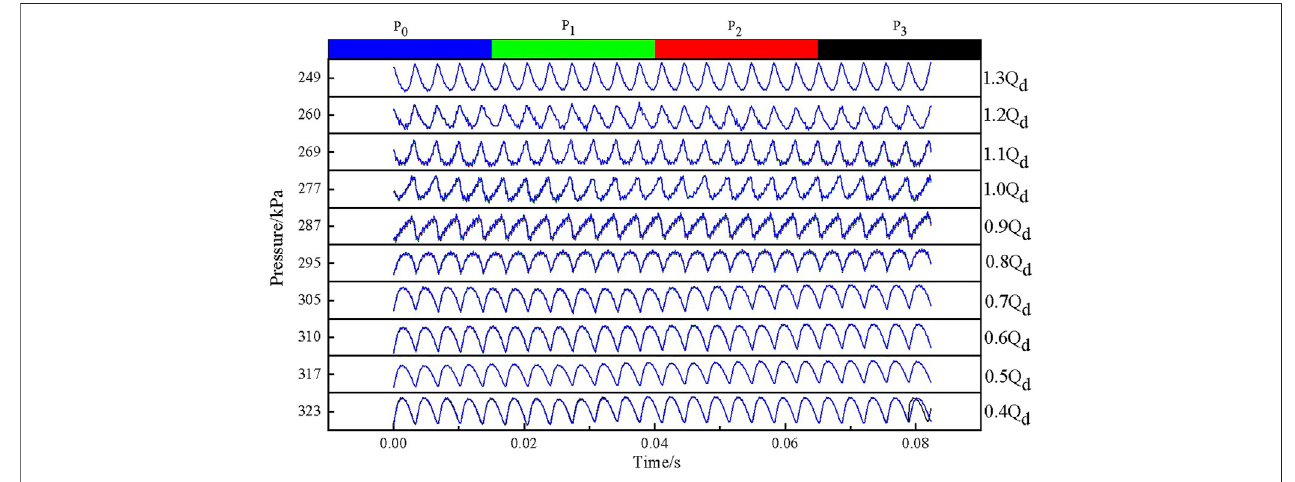
FIGURE 8 | Time domain diagram of pressure pulsation under partial conditions.